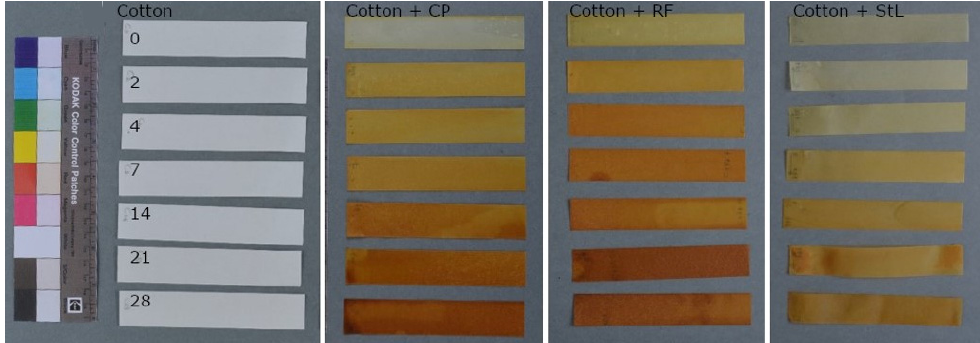
Figure 1. The four sets of mock-ups recorded with visible light photography.